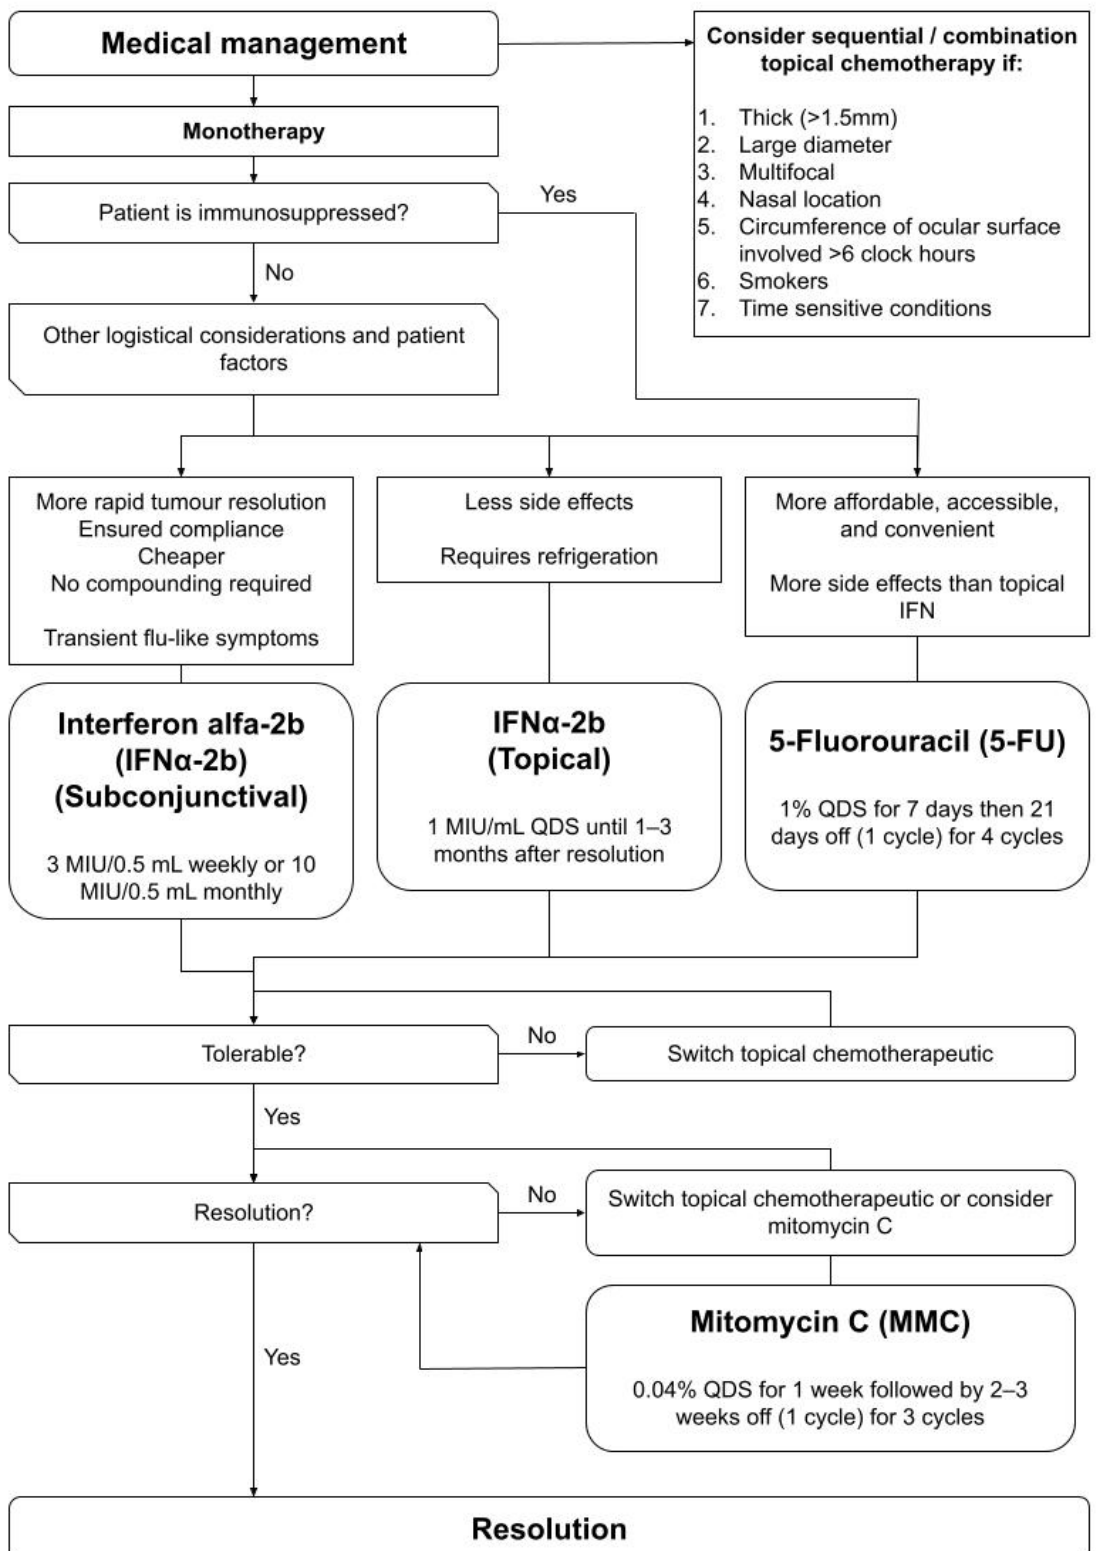
Figure 3. Flowchart guiding the choice of topical chemotherapy as primary medical therapy for OSSN, and the need for sequential or combination topical chemotherapy.